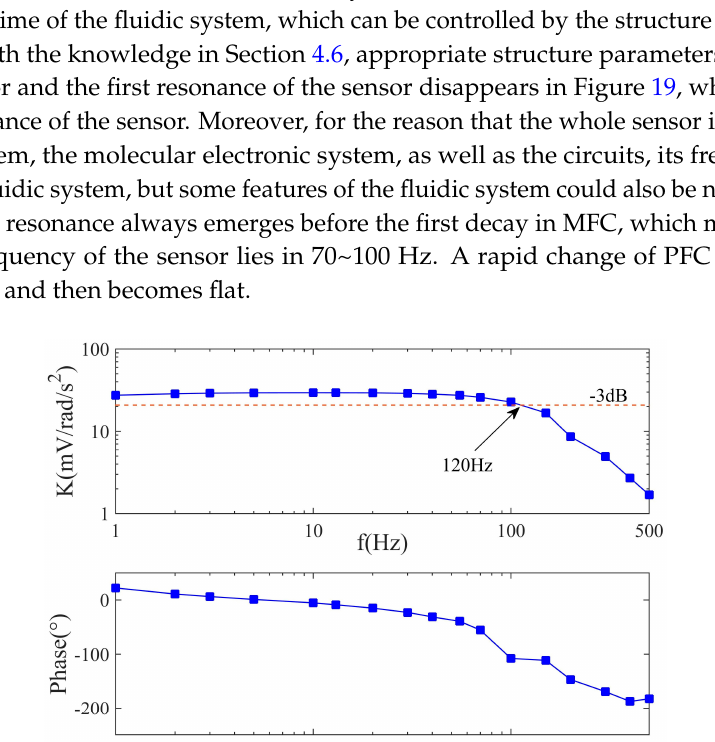
Table 5. Indexes of LCAA.